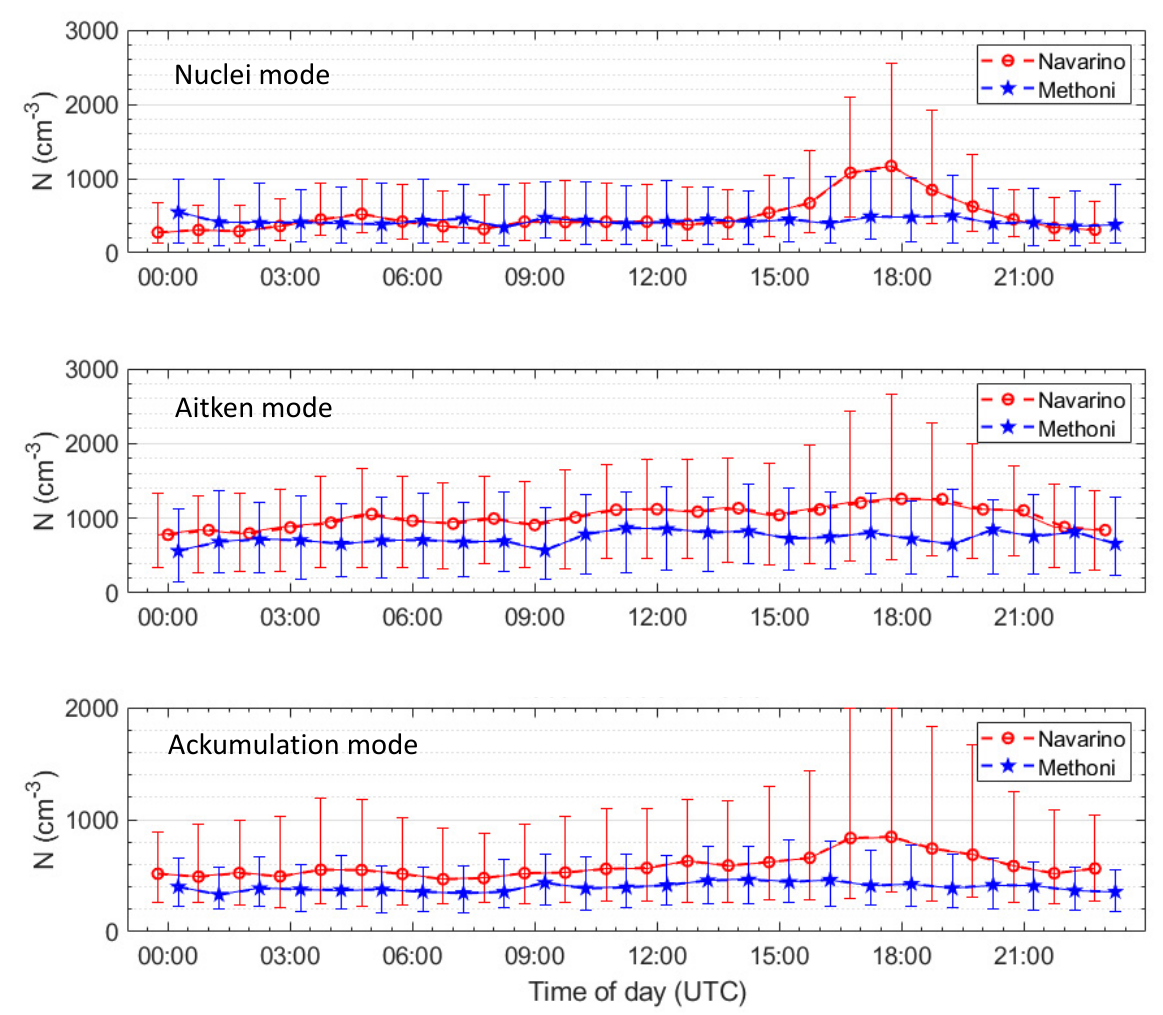
Figure 9. Diurnal variation of number concentration of nuclei, Aitken and accumulation modes for the warm period May–September (observations for the period April 2011–September 2013) and at Methoni (observations for the period November 2013–December 2016). The dotted curves indicate the median values while the error bars indicate the inter-quartile range.